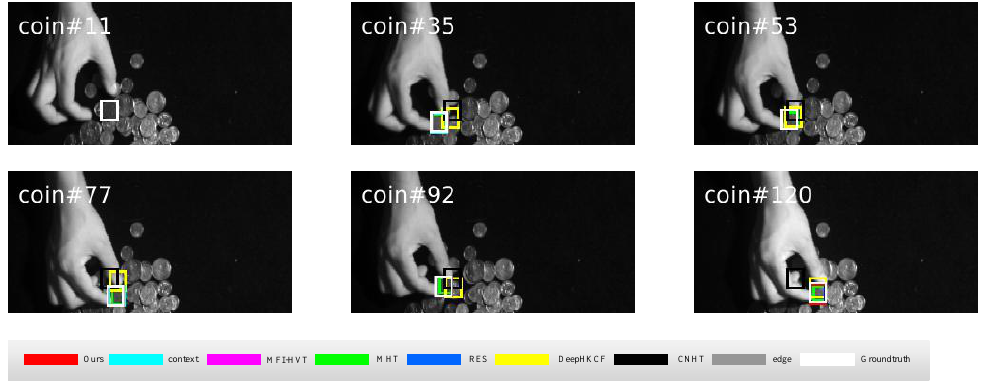
Figure 11. Qualitative outcomes for the coin